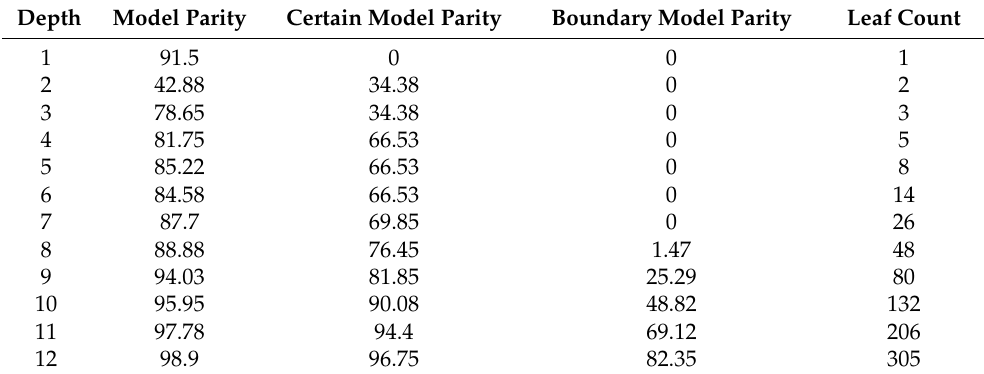
Table 2. Evaluation of the interpretable models for the circle function generated by MTRE-PAN at depths ranging from 1 to 12.